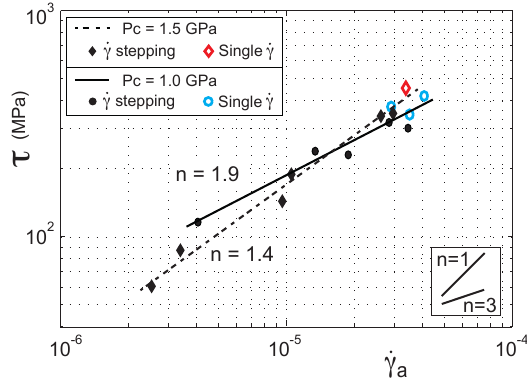
Figure 3. Determination of stress exponents. Shear stress, τ (MPa), versus apparent shear strain rate, ˙ γ a . Two stress exponents, n , are obtained using constant strain rate data and strain rate stepping ex- periments. For experiments at confining pressures, Pc = 1.0GPa, n = 1 . 9; for Pc = 1.5GPa, n = 1 . 4. Data for Pc = 1.0GPa from Marti et al. (2017).